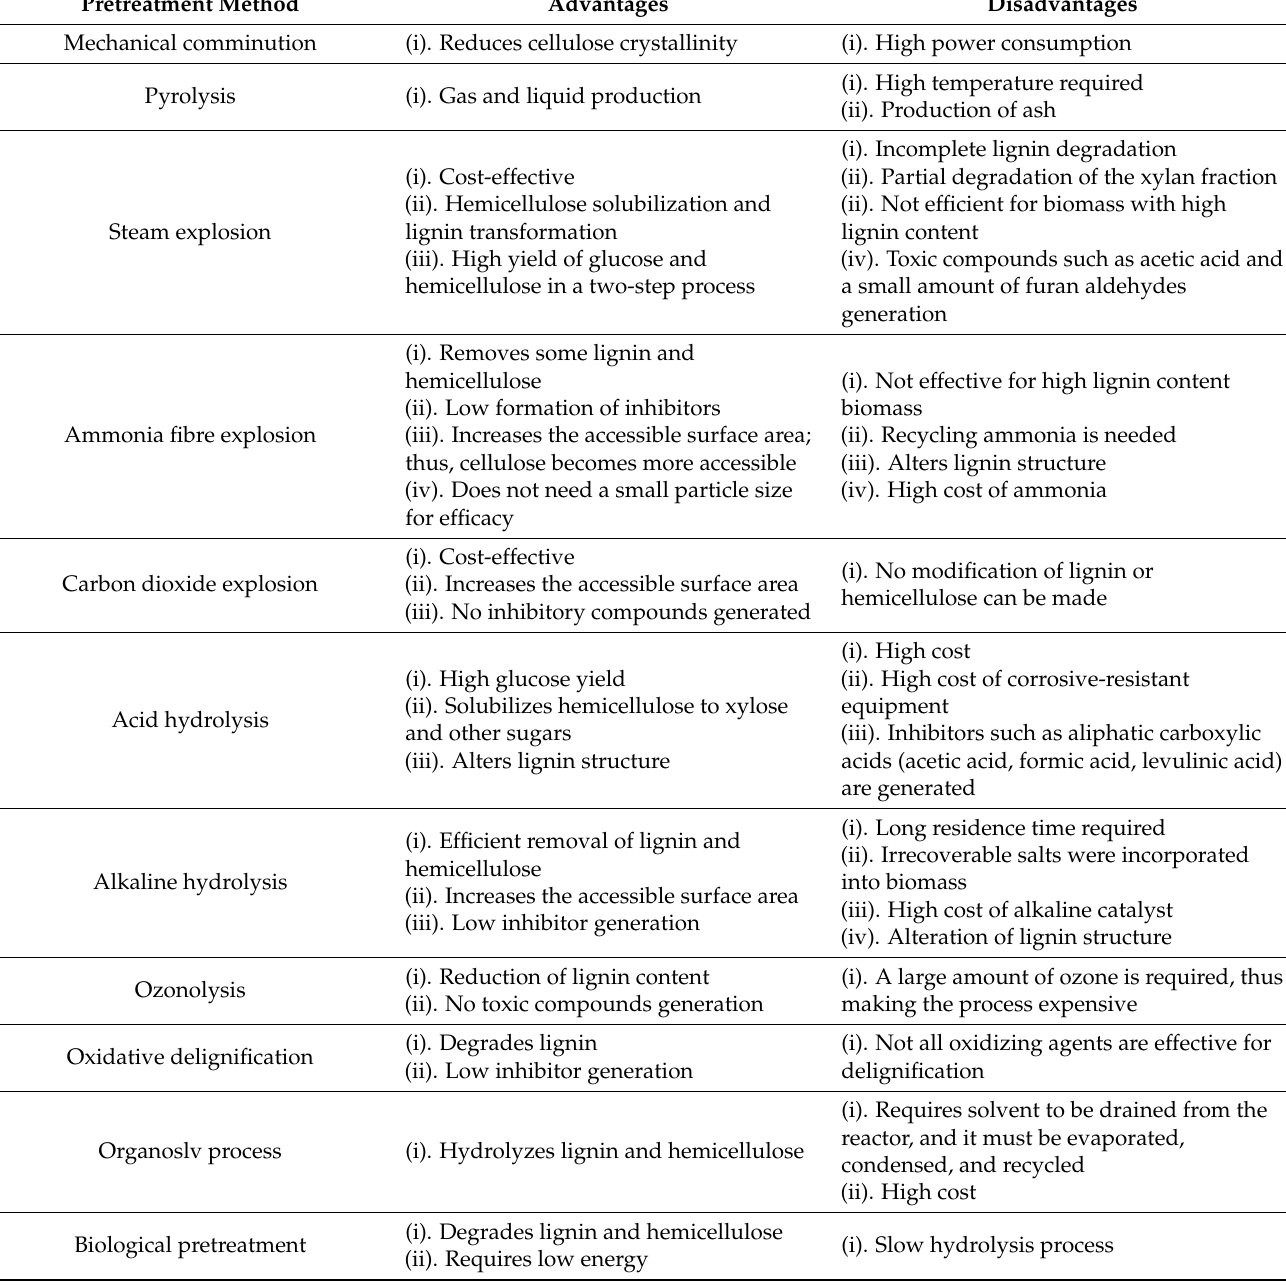
Table 2. A summary of various lignocellulosic biomass pretreatment processes and quantitative